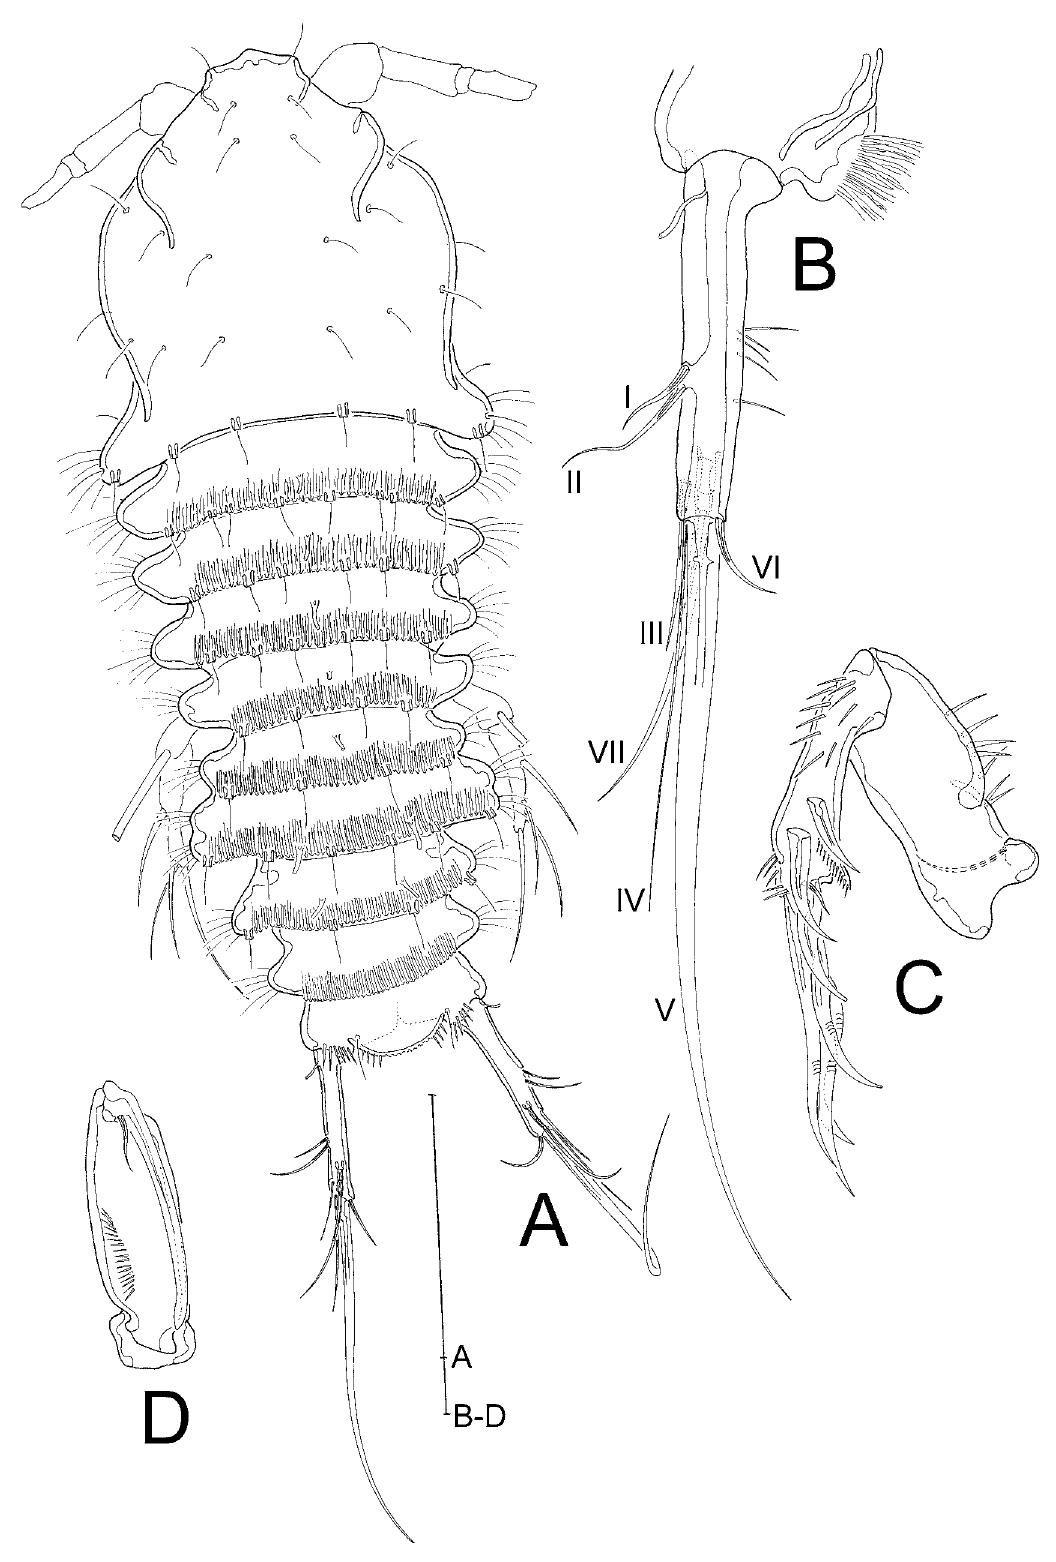
Fig. 7. Laophontodes scottorum sp. nov., holotype, ♀ (BMNH 1911.11.8.44995). A . Habitus, dorsal view. B . right furcal ramus, ventral view. C . A2. D . Mxp. Scale bar: A = 100 µm, B–D = 50